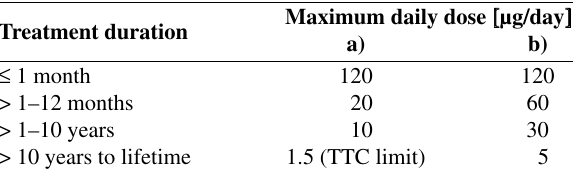
Table 1. Acceptable intakes for less-than-lifetime (LTL) to lifetime exposures for a) an individual impurity and b) for multiple